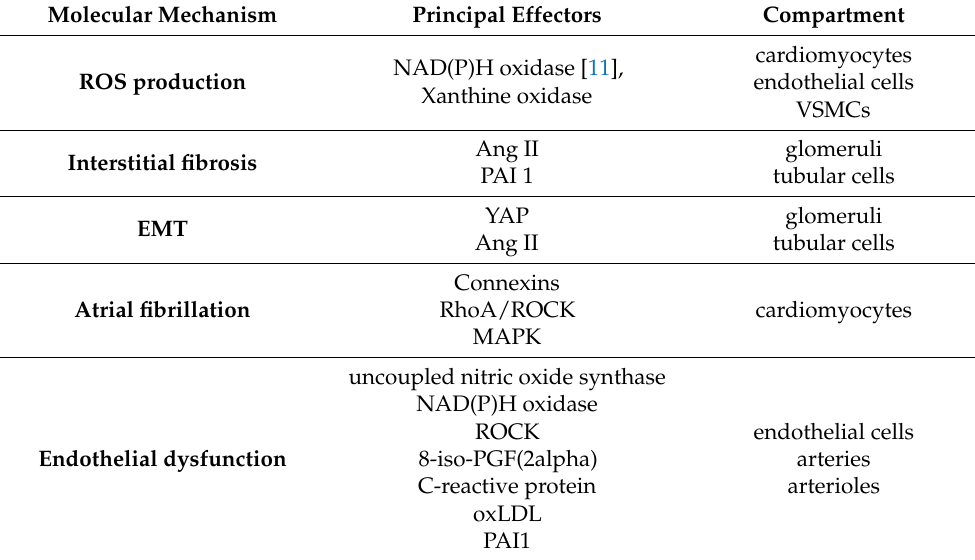
Table 1. Schematic summary of molecular mechanism involved in the cardiovascular-renal remodel- ing. To the molecular mechanisms taking part to the cardiovascular-renal remodeling listed in the table, correspond the principal effectors involved and the relative compartment where the mech- anisms take place. ANG II—angiotensin II; PAI 1—plasminogen activator inhibitor 1; YAP—yes associated protein; RhoA/ROCK—Rho kinase; MAPK—mitogen activated protein kinase; oxLDL— oxidized low density